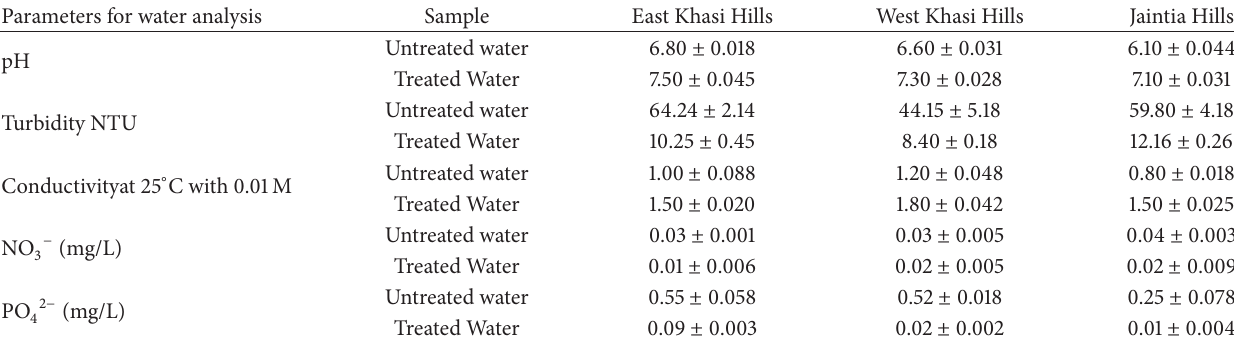
Table 2: Parameters analyzed in treated and untreated water.